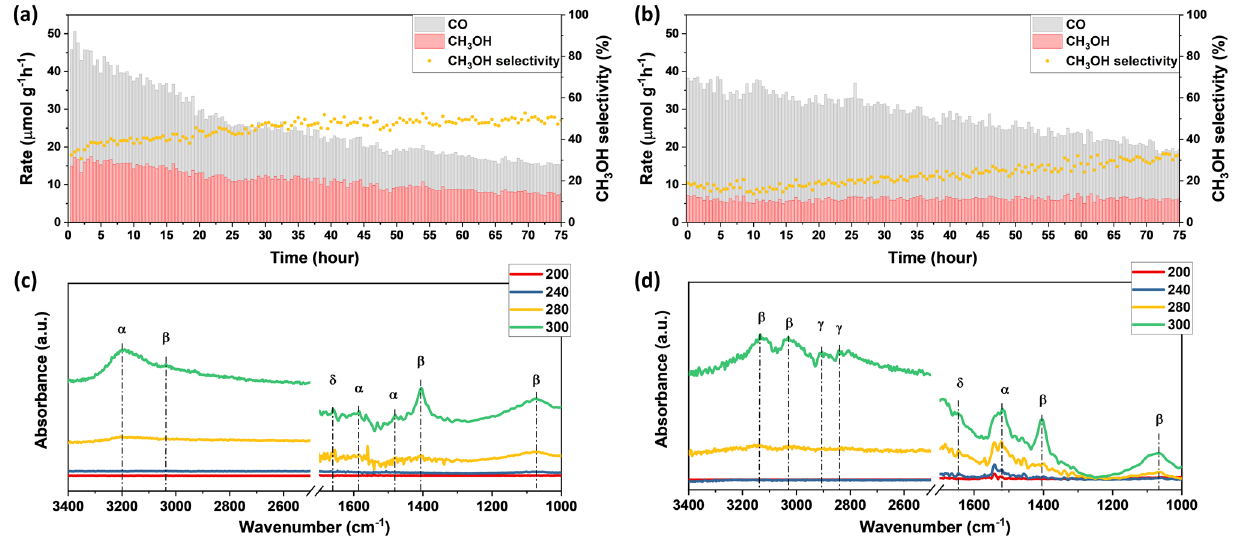
Fig. 3 Stability test and in-situ DRIFTS analysis. Seventy- fi ve hours continuous stability test for S2 at 250 °C with light under a 75% H 2 and b 50% H 2 . Reaction conditions: atmospheric pressure, H 2 /CO 2 ratio of 1:1, a fl ow rate of 4 mL min − 1 , and light intensity of ~6 suns. c In situ DRIFTS of S2 with CO 2 and H 2 (1:1) and d with CO and H 2 (1:1). All DRIFTS spectra were subtracted by the background signal of S2 obtained under He. α : C = O stretching vibrations (formate); β : C – H and C – O stretching vibrations (methoxy); γ : C – H stretching vibrations (methanol); δ : H – O stretching vibrations (H 2